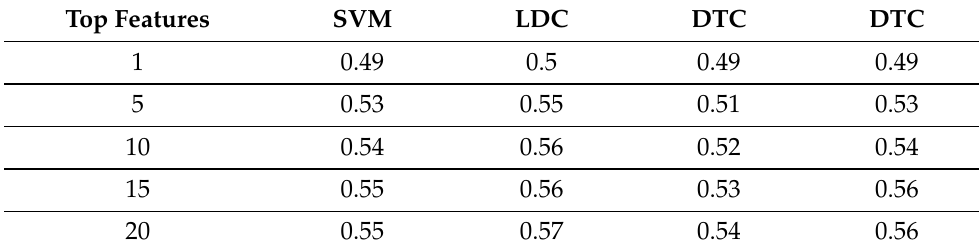
Table 2. Accuracy comparison of low number of features.